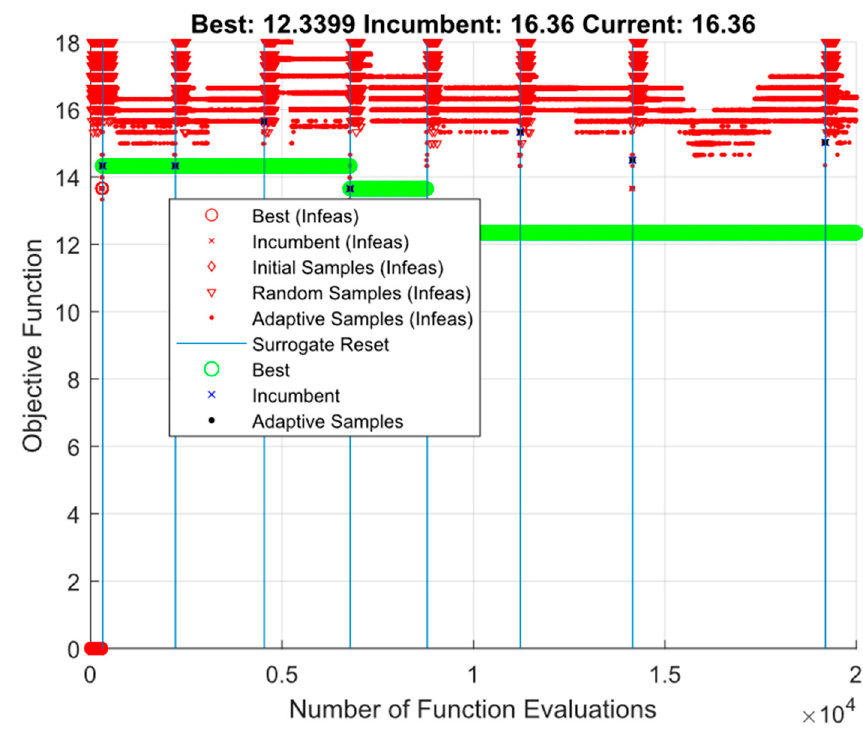
Figure 5. Solution of the task (Variant #2).